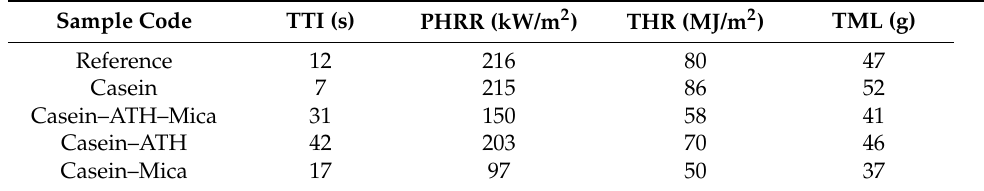
Table 2. The calorimetry results (average of two analyses) of an uncoated and composite coated wood specimen with time to ignition (TTI), peak heat release rate (PHRR), total heat released (THR), and total mass loss